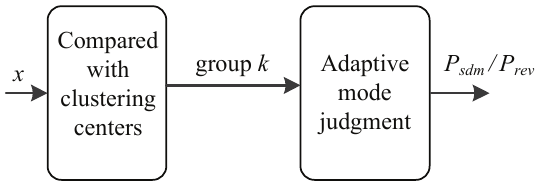
Figure 2. The principle of the Identify similar days .